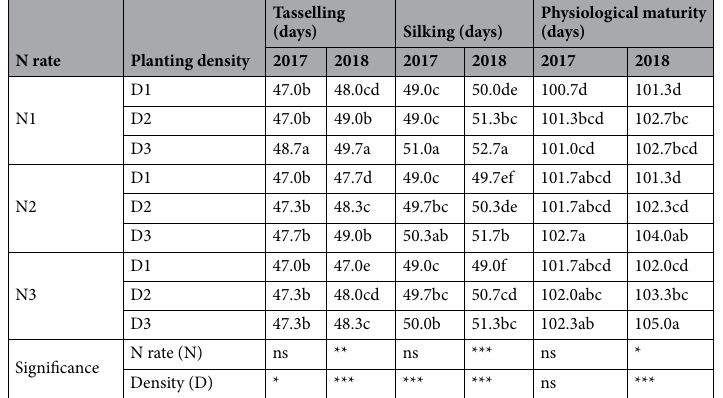
Table 1. Phenology in 2017 and 2018. The three N rates are 120 (N1), 180 (N2), and 240 (N3) kg ha −1 . The three planting density levels are 60,000 (D1), 75,000 (D2), and 90,000 (D3) plants ha −1 . ns no significant difference. Means within a column followed by the different letter are not significantly different at P < 0.05 as determined by the LSD test. *, **, and *** indicate significant difference at 0.05, 0.01 and 0.001 level,